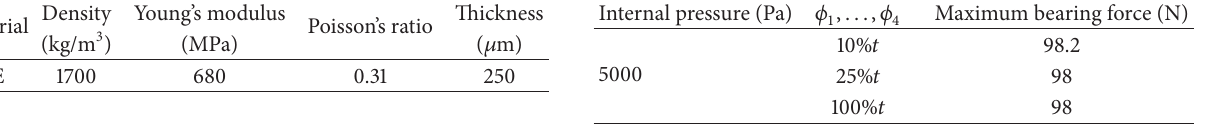
Table 3: Comparison of critical bearing capacity between experi- ment and IMP model.